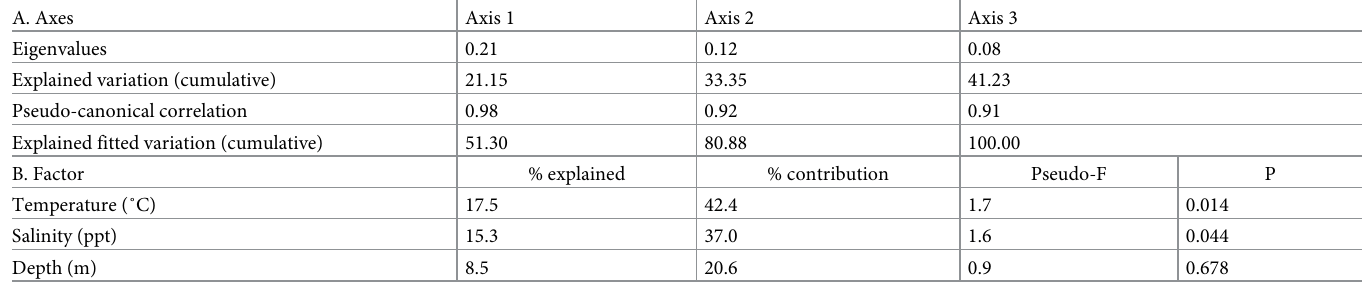
Table 4. Results of redundancy analysis (RDA) from deep-sea camera deployments. A. RDA on square root-transformed MaxN deep-sea community data with envi- ronmental (temperature, depth, salinity, and distance to open ocean). B. Conditional effects of Monte-Carlo permutation results on the redundancy analysis (RDA). A. Axes